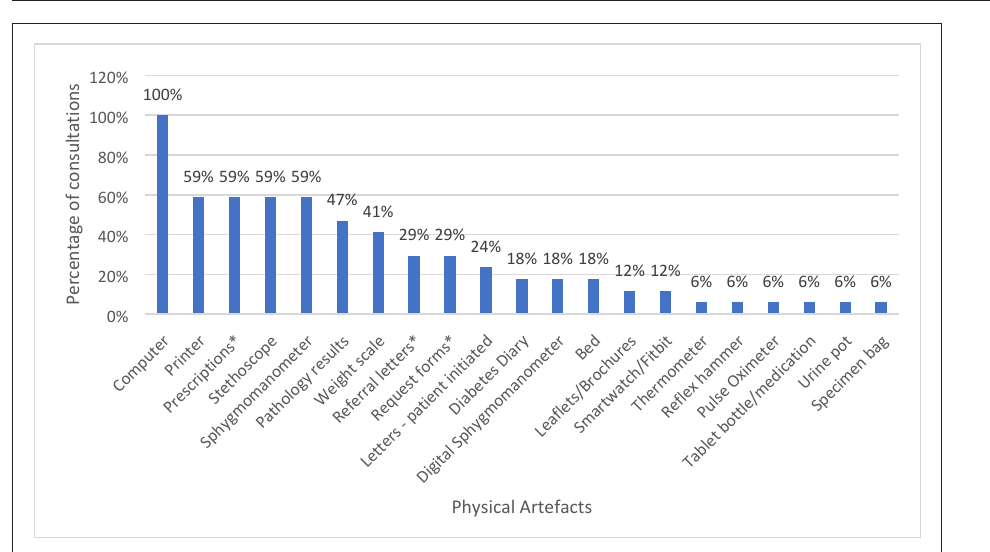
Figure 2: Frequency of physical artefacts used during in-person consultations (n = 17) *Physical artefact dispensed either by GP or at GP reception